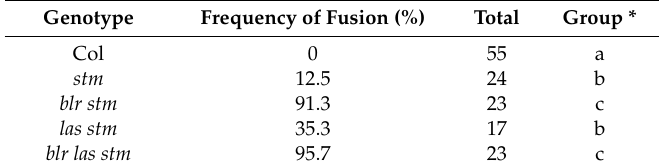
Table 4. Frequency of cotyledon fusion in stm mutant combined with blr and las